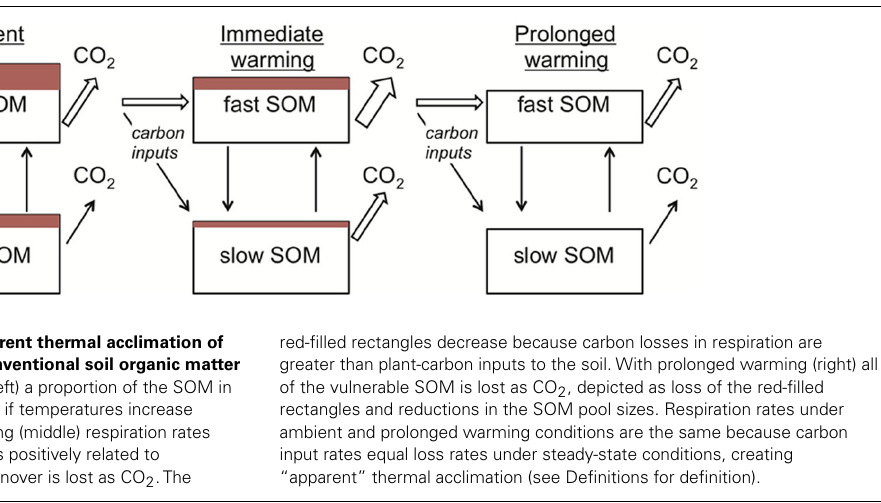
red-filled rectangles decrease because carbon losses in respiration are greater than plant-carbon inputs to the soil.With prolonged warming (right) all of the vulnerable SOM is lost as CO 2 , depicted as loss of the red-filled rectangles and reductions in the SOM pool sizes. Respiration rates under ambient and prolonged warming conditions are the same because carbon input rates equal loss rates under steady-state conditions, creating “apparent” thermal acclimation (see Definitions for